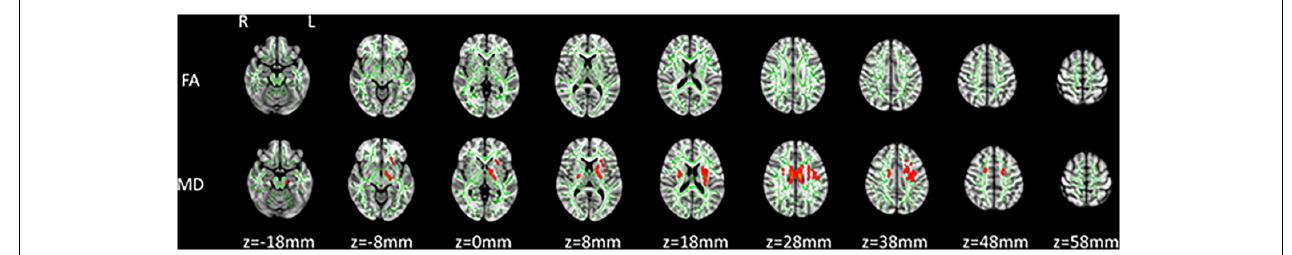
FIGURE 1 | Tract-based spatial statistics (TBSS) analysis of asymptomatic carriers at baseline compared with follow-up. Increased mean diffusivity (MD) was detected by TBSS analysis in asymptomatic prion protein gene ( PRNP) G114V mutation carriers at follow-up relative to baseline [family-wise error (FWE) correction, P < 0.05]. Significant areas of increased MD (red code) in asymptomatic carriers at follow-up relative to baseline are shown with the skeleton (green